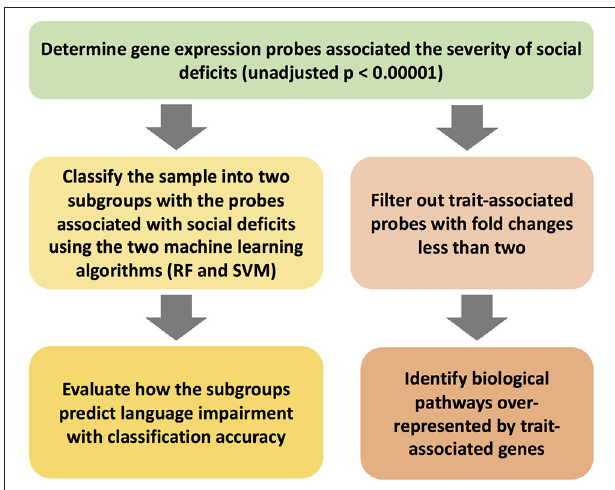
FIGURE 1 | The workflow of the study scheme.